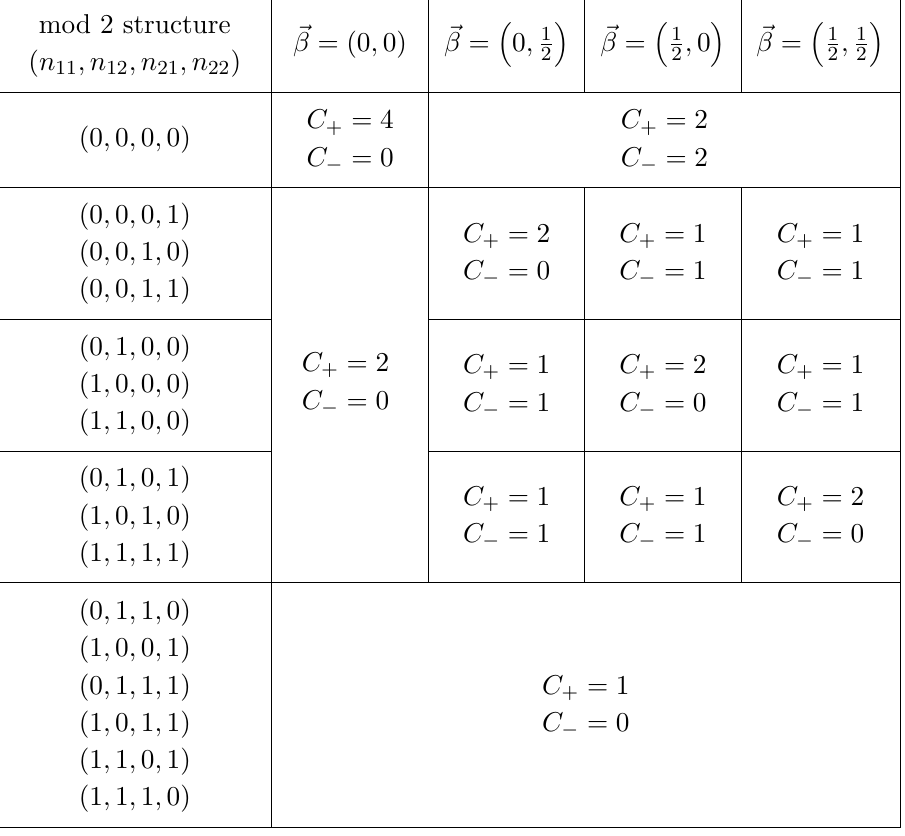
Table 2 . C ± when ~α = (0 , 0)